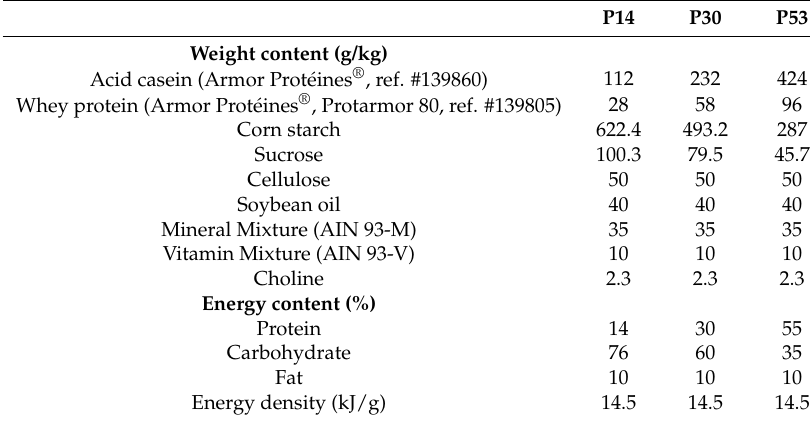
Table 1. Composition of the experimental